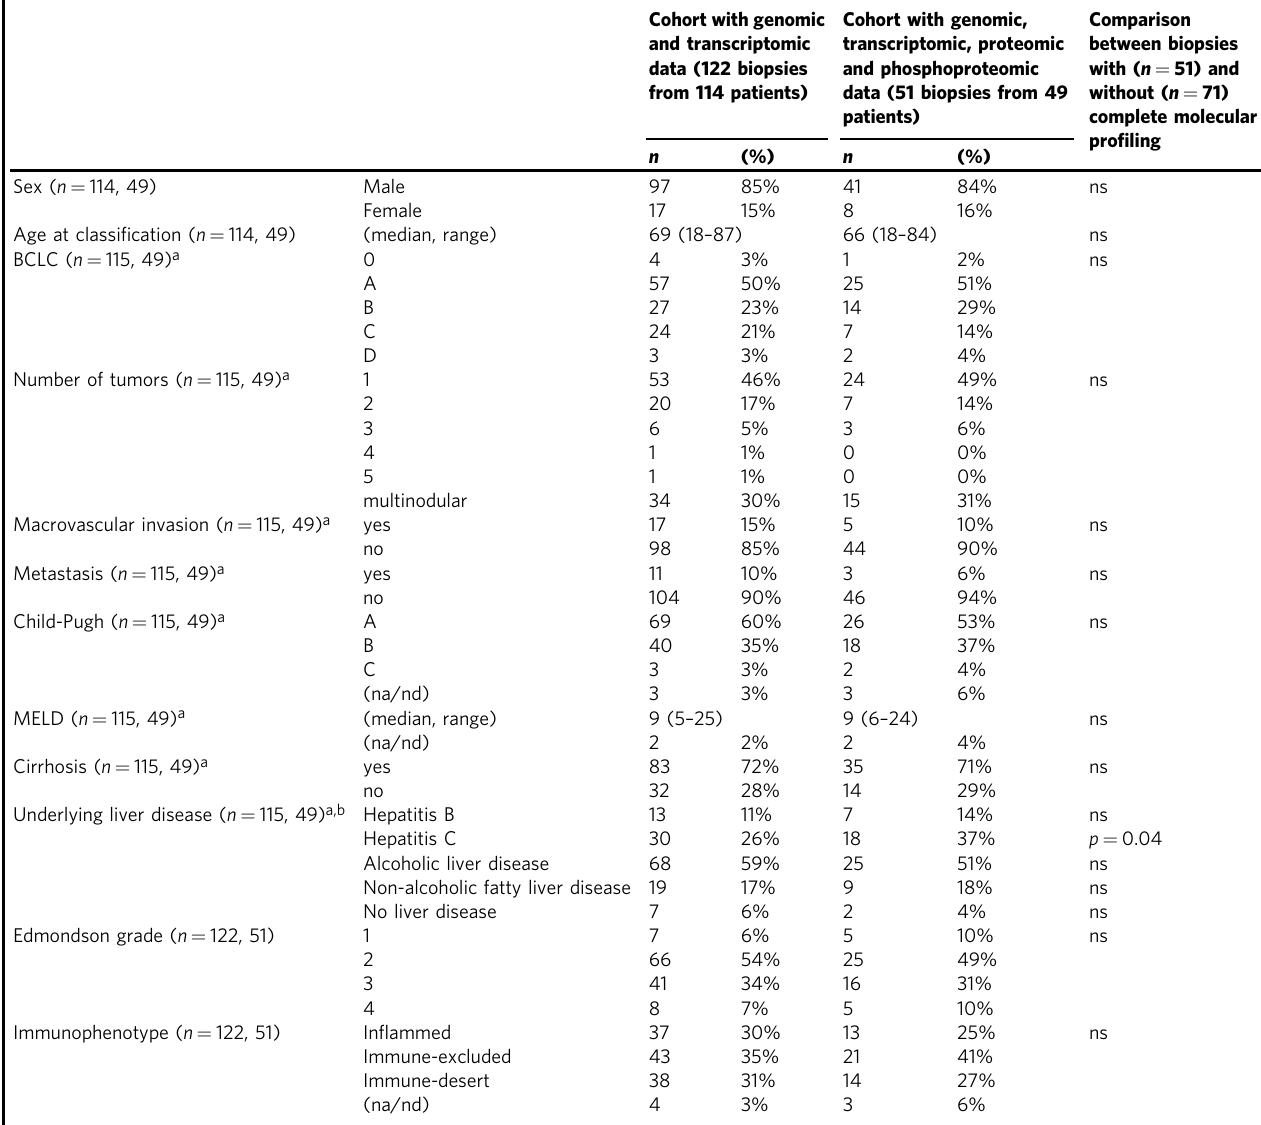
Table 1 Summary of clinicopathological information of the cohort.